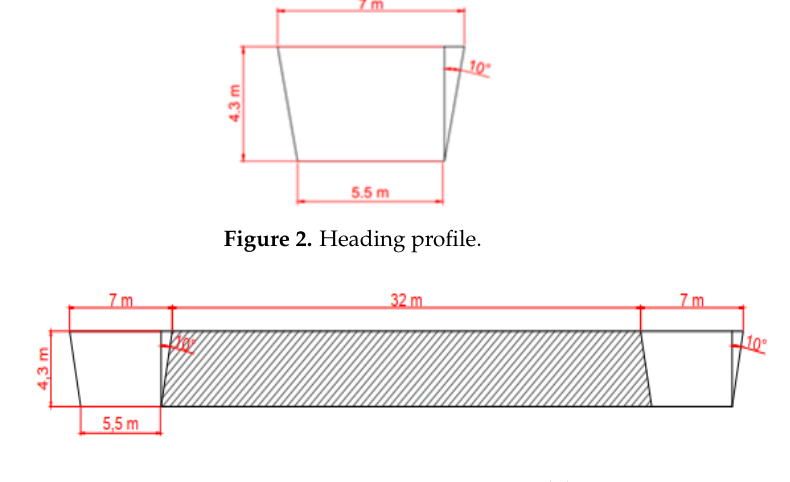
6 of 16 Table 1. Geometric cross-section data. Parameter